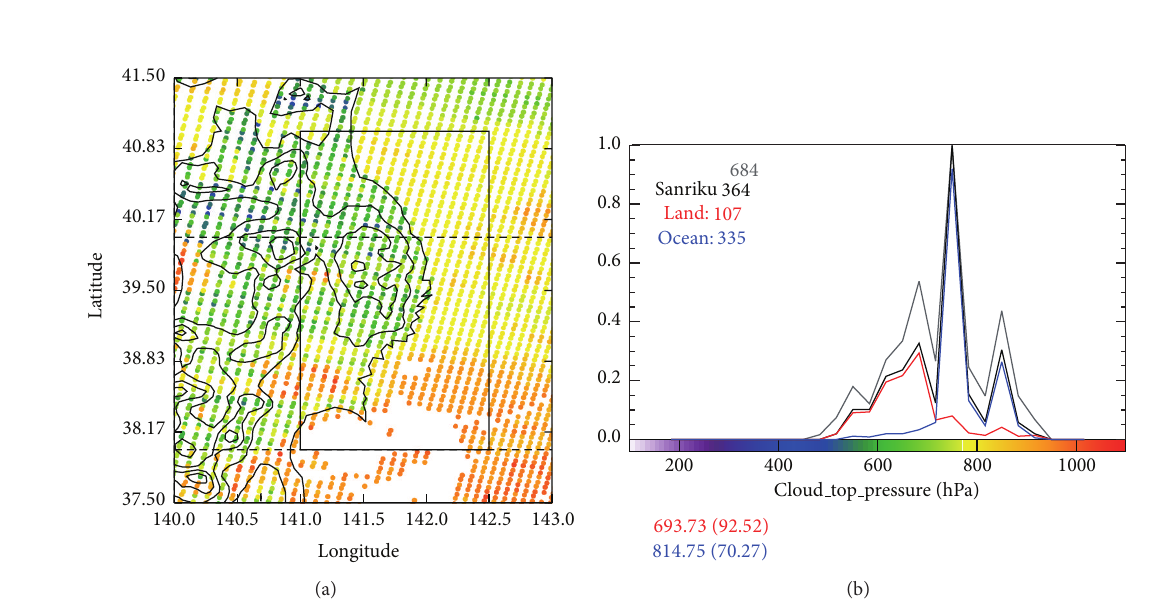
Figure 11: Same as Figure 3 but at 0150 UTC July 16,